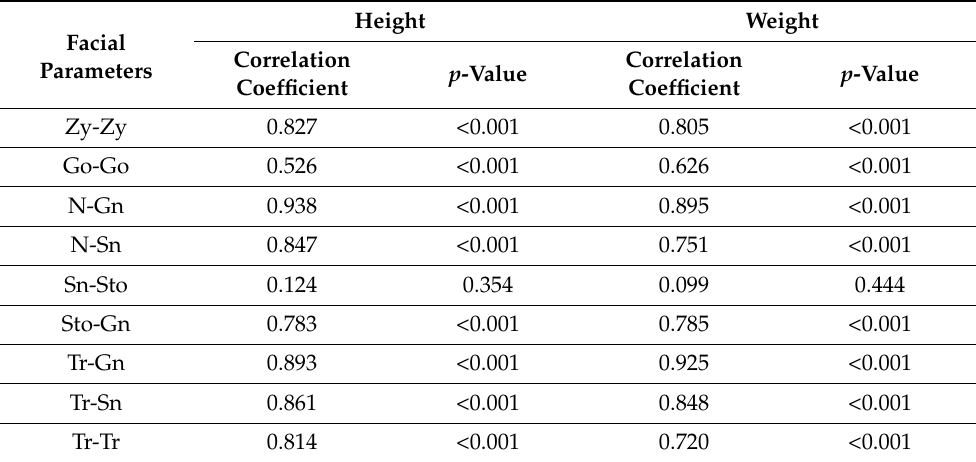
Table 5. The correlations between facial parameters and general growth